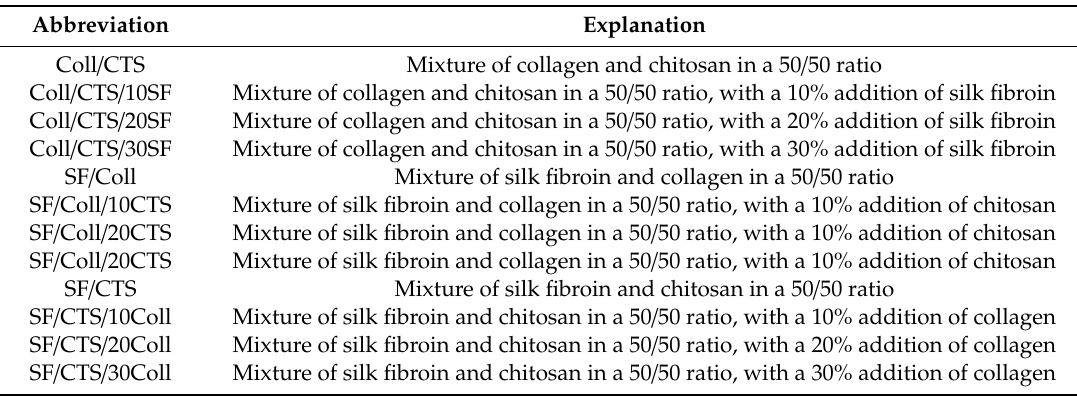
Table 1. The materials’ abbreviations and their